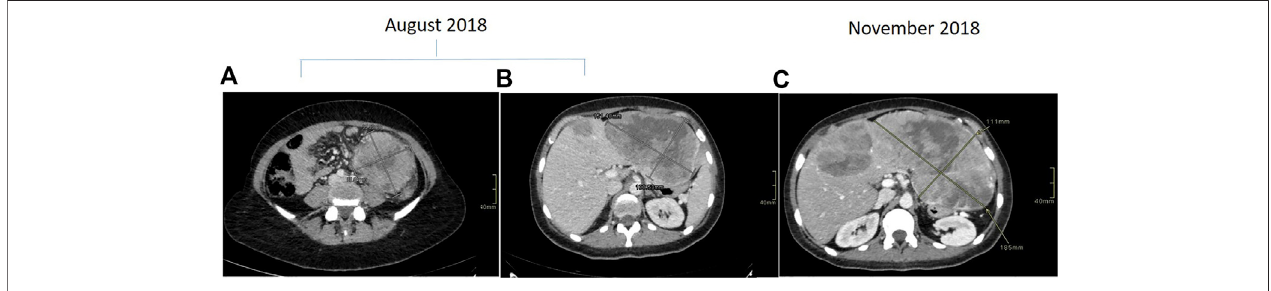
FIGURE 1 | Contrast enhanced CT scan demonstrating descending colon cancer at baseline (A) and liver metastasis at baseline (B ) and at progression (C)